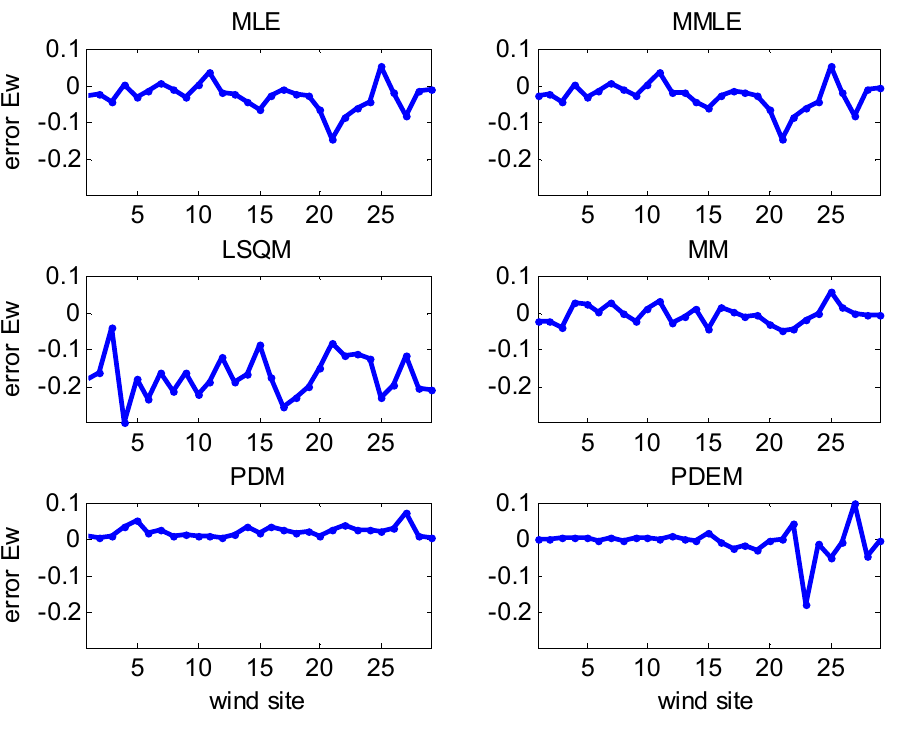
at the different wind sites. Ew